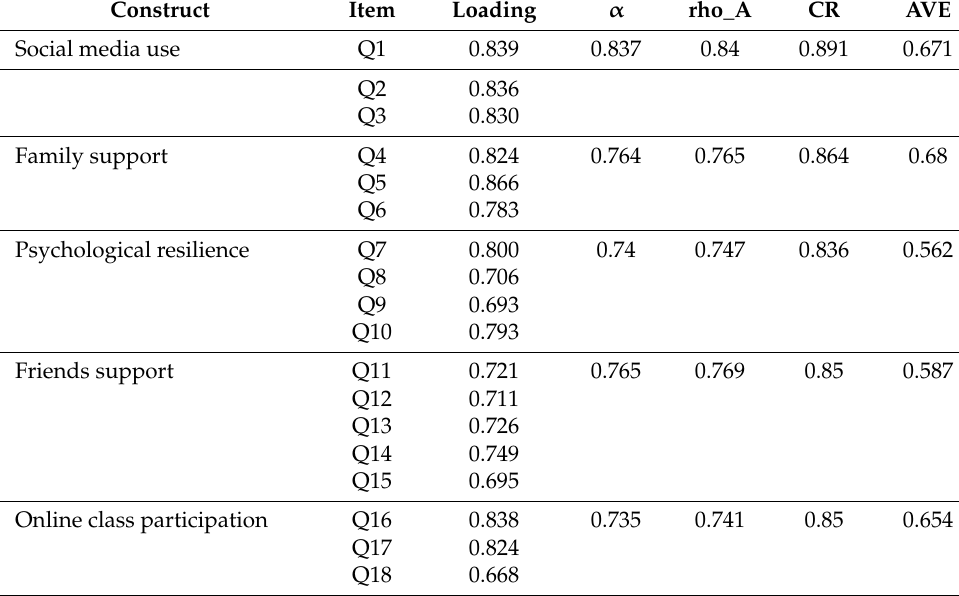
Table 2. Reliability and convergent